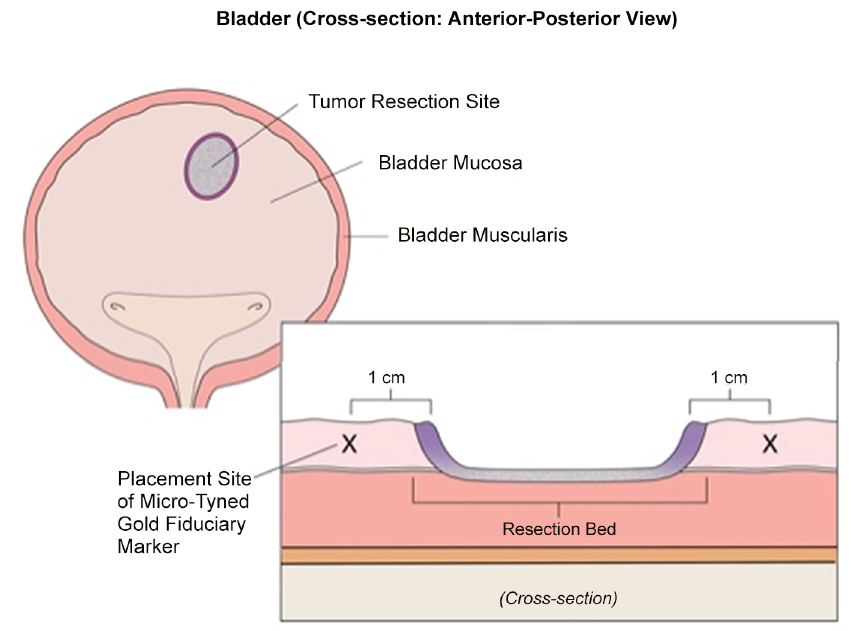
Figure 2. The tumor resection site is marked by a minimum of three fiducial markers placed circumferentially. Electrocautery will cause necrosis of mucosa immediately adjacent to the resection site ( purple ). For this reason, we place the fiducial markers into healthy mucosa , 5– 10 mm lateral to the resection margin (‘‘X’’).